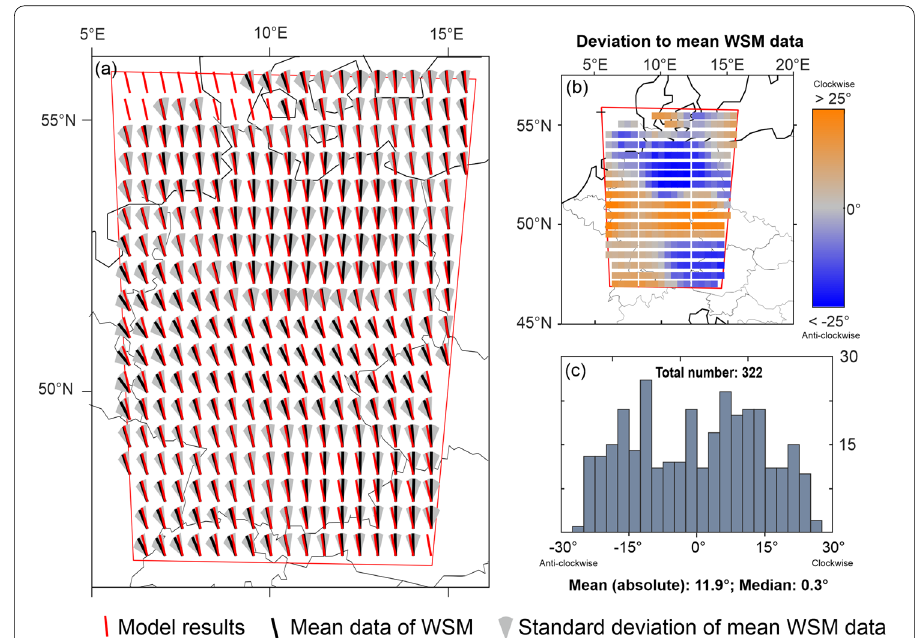
Fig. 5 Orientation of S Hmax predicted by the model in comparison to the mean orientation of the WSM (Heidbach et al., 2016) and Levi et al. (2019). Details are described in the text. a Model results at 5 km TVD (red lines), the mean orientation derived from the WSM (black lines) with standard deviation (grey wedges). b Color‑coded deviation between the results and the mean orientation of the WSM. Blue indicates an anti‑clockwise rotation of the model results and orange a clockwise rotation of the model results w.r.t the mean orientation of the WSM. c Histogram showing the deviation displayed in a and